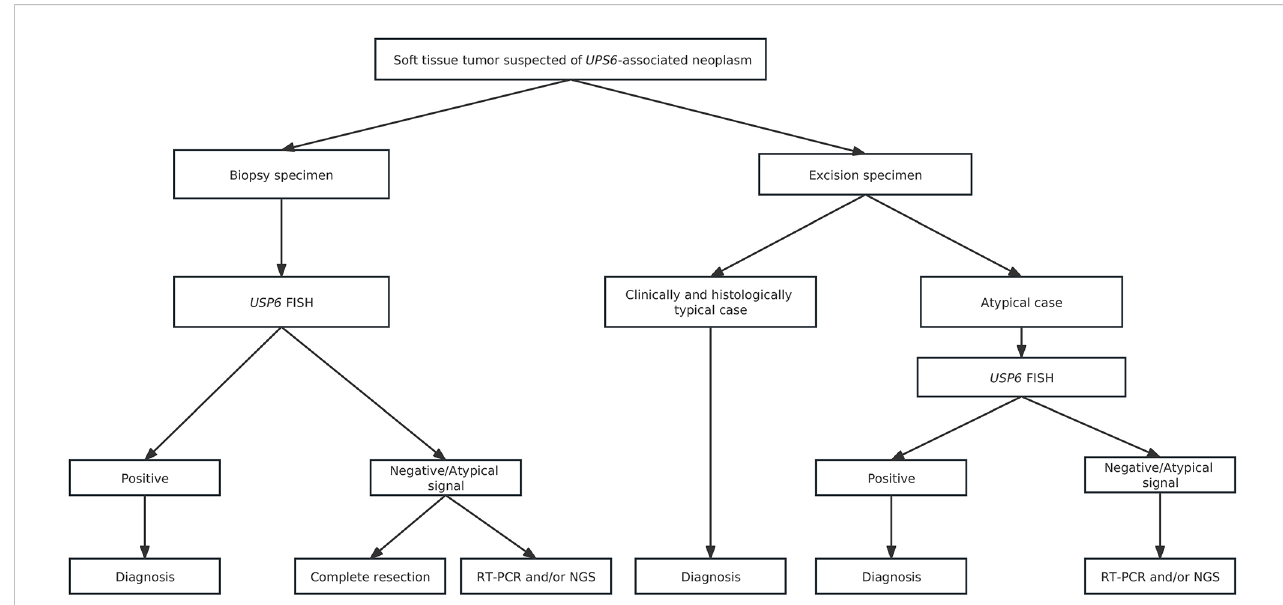
FIGURE 8 Diagnostic algorithm for soft tissue tumors suspected of UPS6 -associated